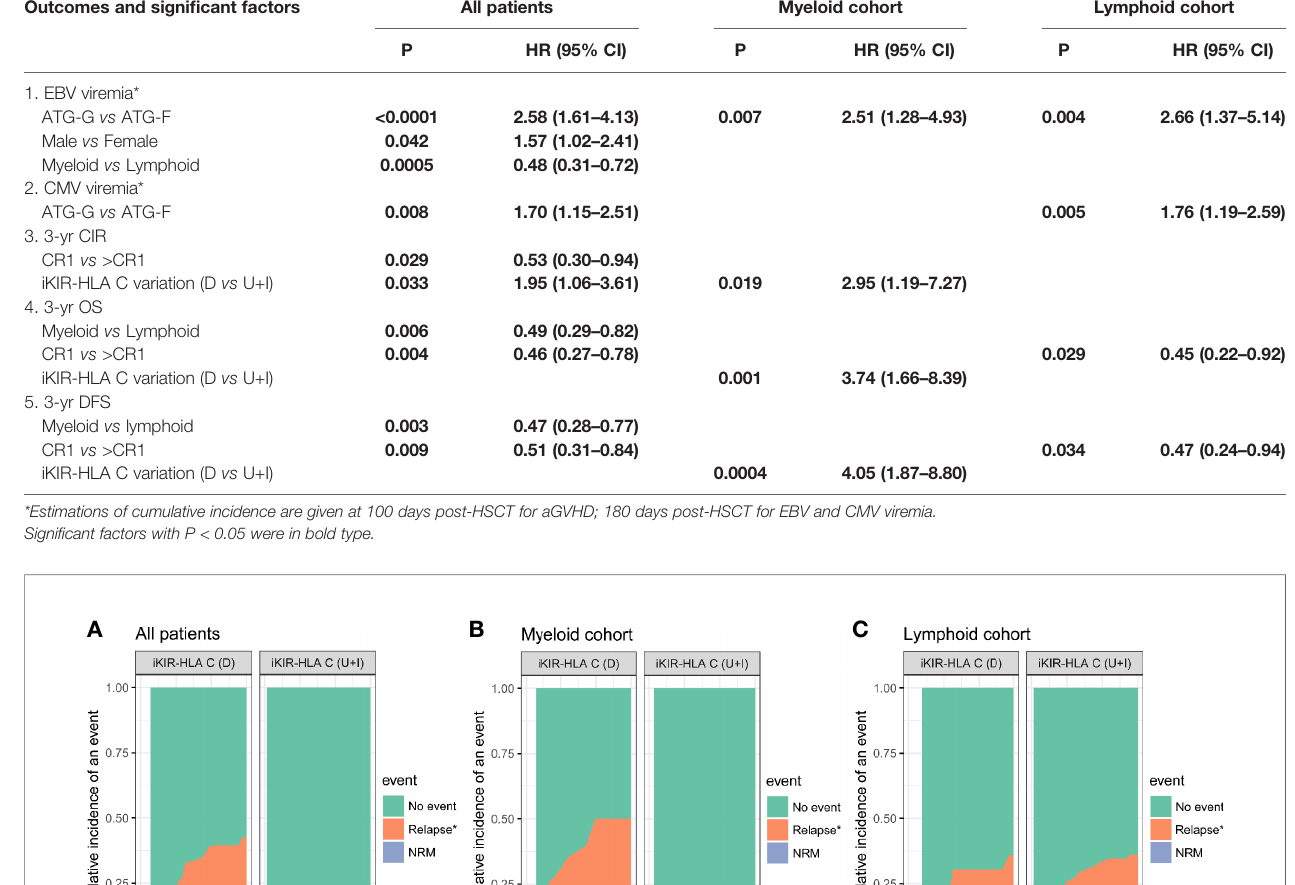
TABLE 3 | Multivariate analysis of factors that in fl uence transplant outcomes. Outcomes and signi fi cant factors All patients